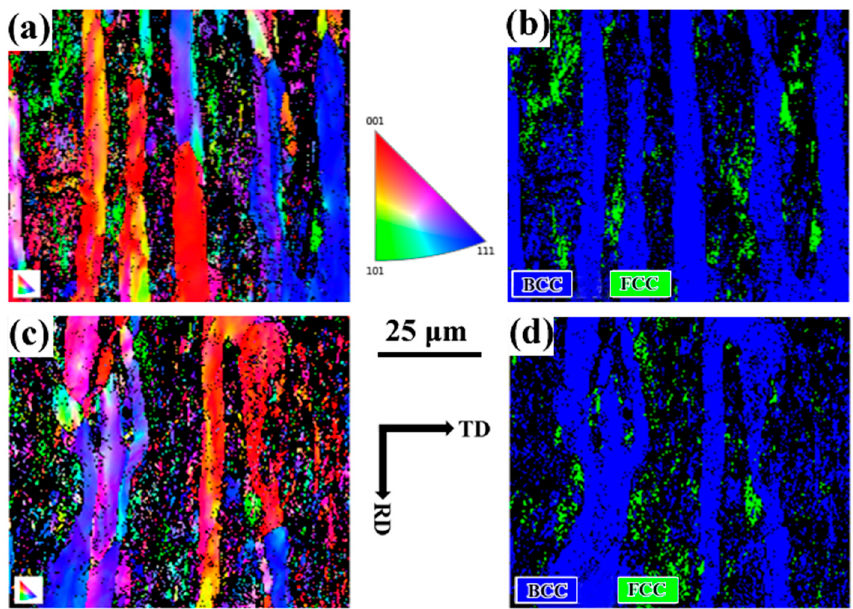
Figure 9. EBSD orientation maps of the samples after solution treatment at 1050 ◦ C for 5 min and room temperature tensile tests, ( a ) orientation map and ( b ) phase map of Cr19 DSS, ( c ) orientation map and ( d ) phase map of Cr19 + W